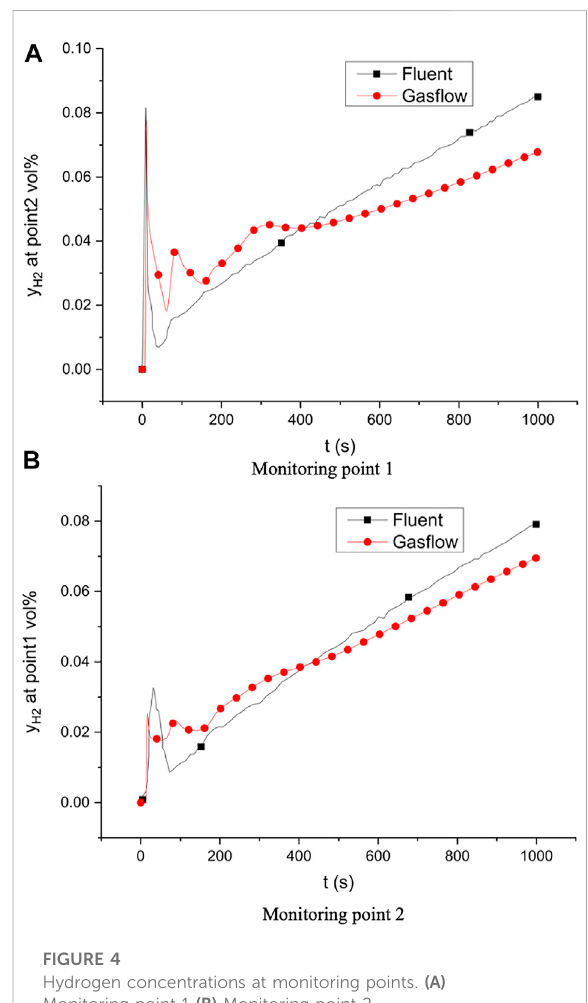
FIGURE 4 Hydrogen concentrations at monitoring points. (A) Monitoring point 1 (B) Monitoring point